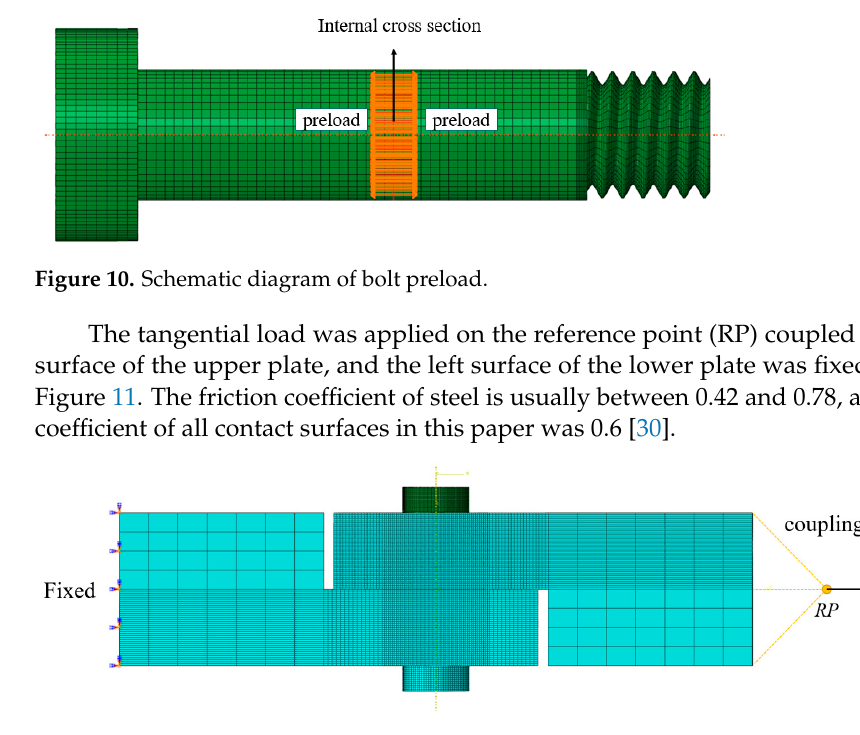
Figure 10. Schematic diagram of bolt preload.